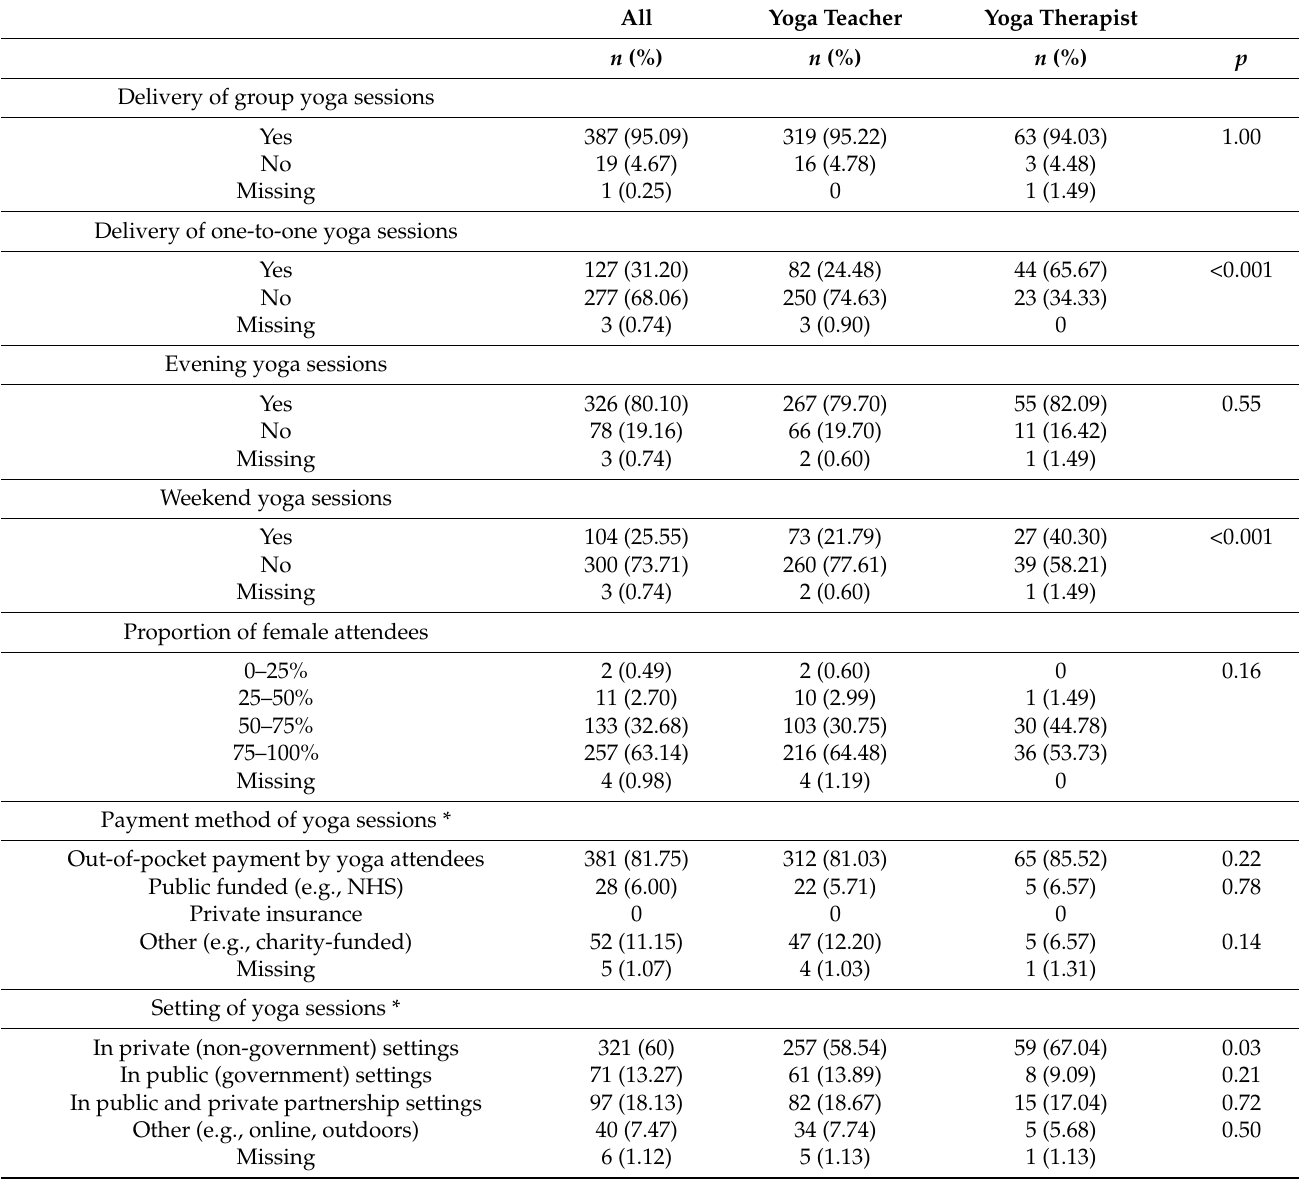
Table 2. Structure, delivery, and cost of yoga